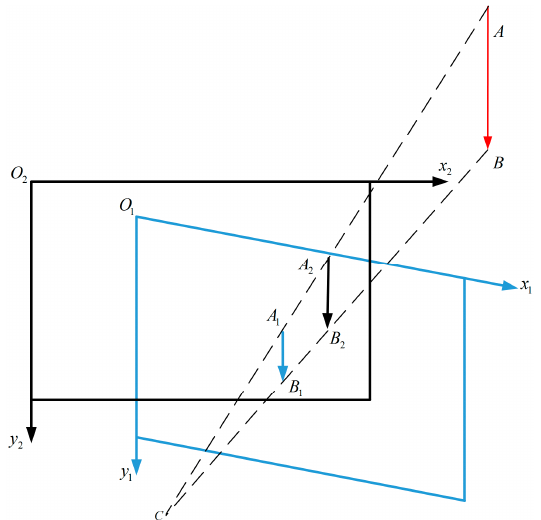
Figure 2. The plumb line in the real world should be a vertical line on the image plane when the camera is placed horizontally in the photoelectric system.